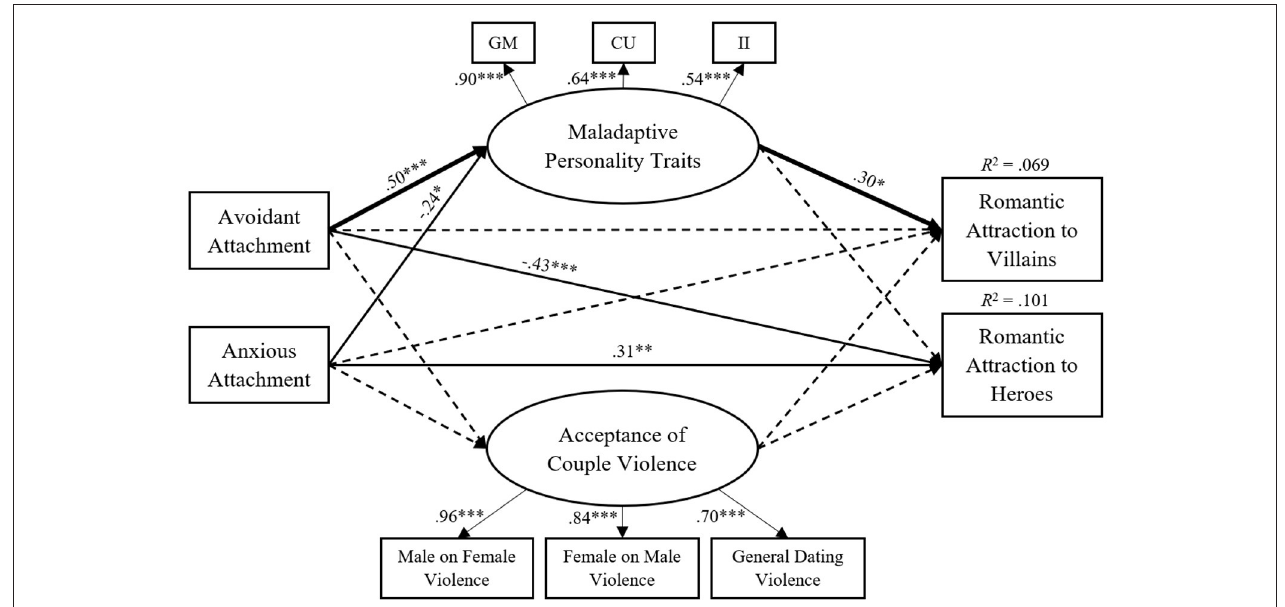
FIGURE 2 | Estimated model for predicting romantic attraction to villains. Standardized estimates of path coefficients. Dashed lines represent nonsignificant relations, and the bold line represents a significant indirect path. * p < 0.05, ** p < 0.01, *** p < 0.001.